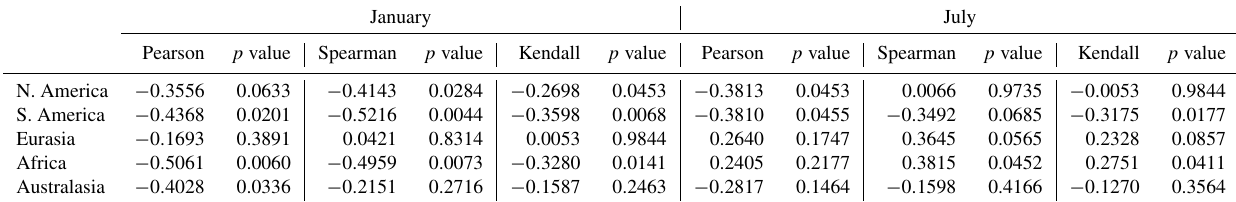
Table 1. Statistical correlations between ˙ H and mean O 3 contribution using the Pearson, Kendall and Spearman correlation coefficients. P values are shown for each corresponding metric. The null hypothesis assumes that no correlation exists between ˙ H and the mean O 3 contribution.